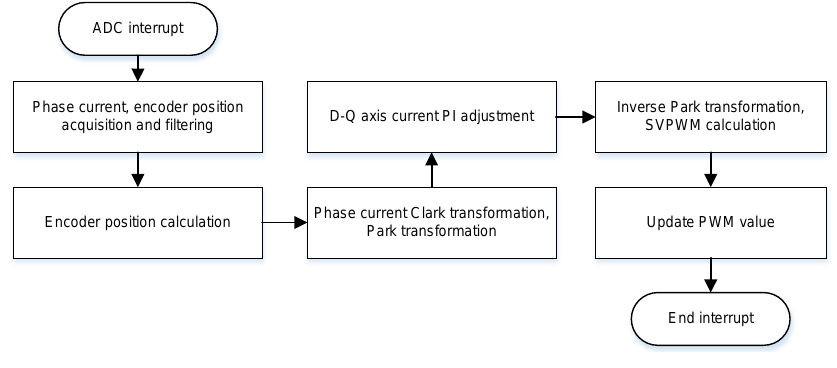
Figure 13. ADC interrupt program flow chart.